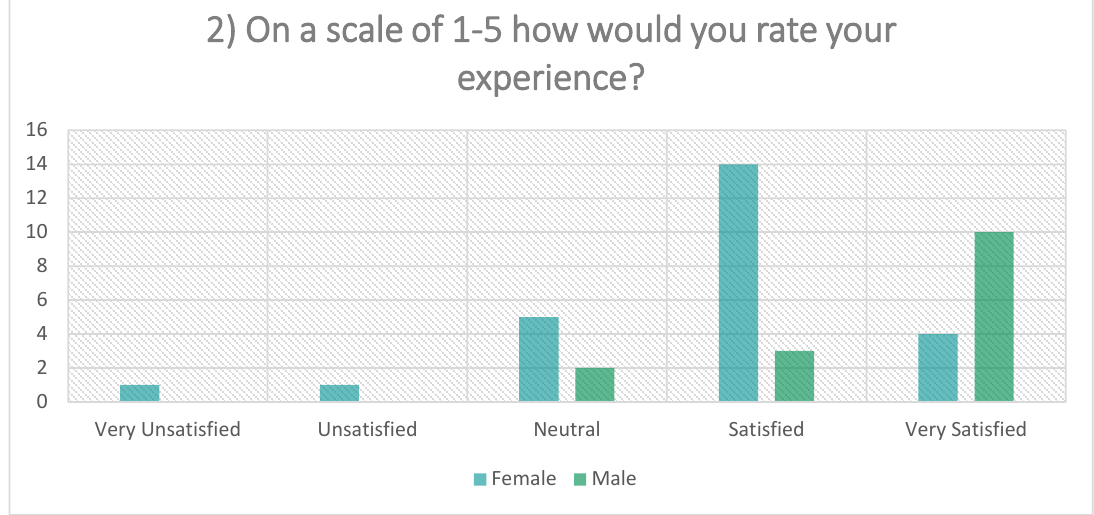
Figure 2. Responses from Question 2: On a scale of 1–5 how would you rate your experience?